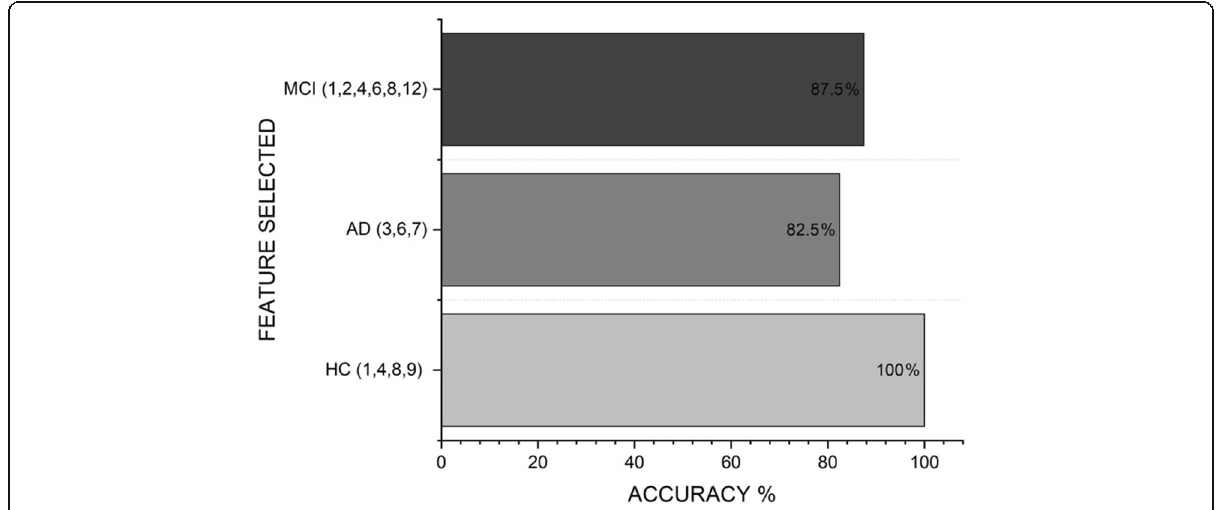
Fig. 3 Accuracy of different classes using SVM polynomial order